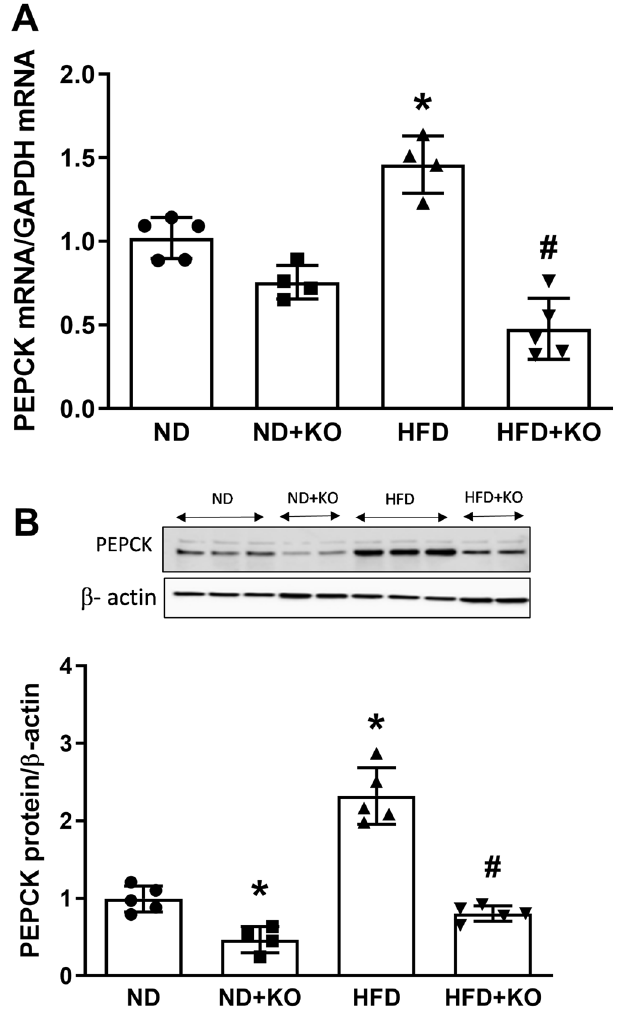
Figure 4. Renal cortical expression of PEPCK. Renal cortical mRNA and protein expression of PEPCK after 8 weeks following normal diet (ND) and high fat diet (HFD) in mice with or without Atp6ap2-KO. Data presented as mean ± SEM, * P < 0.05 versus HFD; # P < 0.05 versus HFD + KO, n = 4–5 each